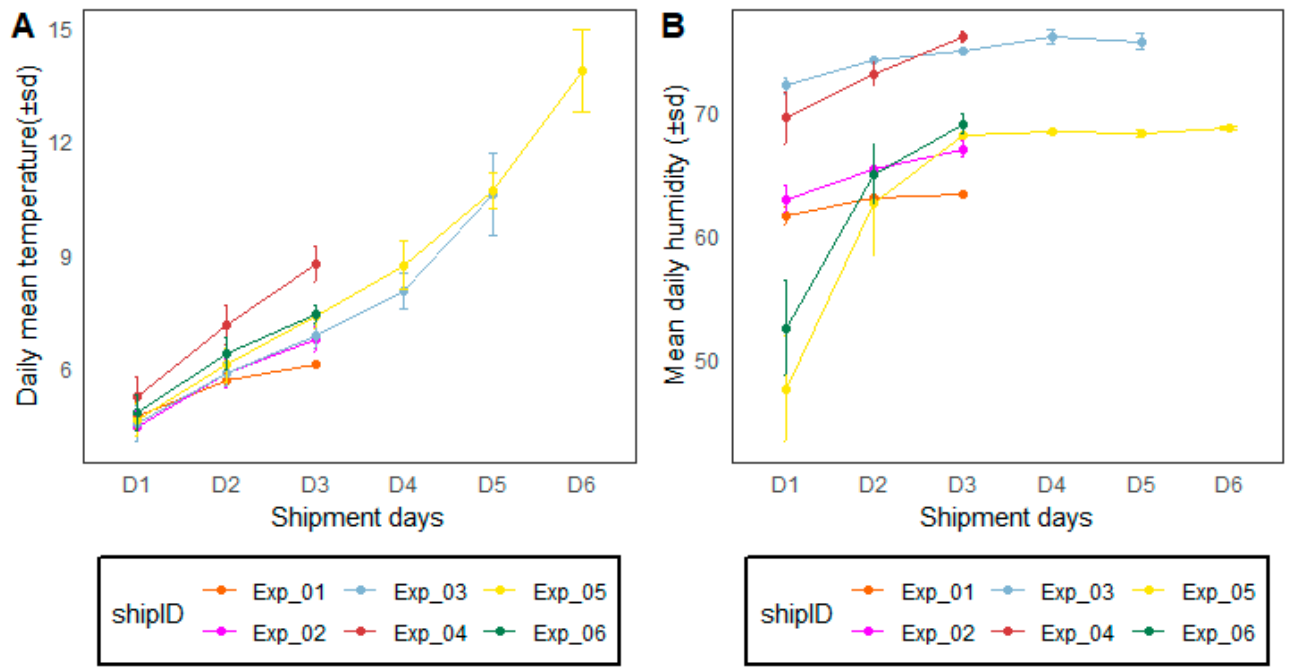
Figure 2. Environmental condition variations including temperature ( A ) and relative humidity ( B ) of six shipments from Seibersdorf, Austria, to Dakar, Senegal, during long-distance transport experiments. Vertical lines separate dates. ‘ShipID’ stands for ‘shipment number (Exp = experiment 01 to 06). ‘D’ stands for ‘shipment day’. Data were recorded using loggers placed at the bottom and top of the mosquito compaction boxes. Loggers were in contact with the Phase Change materials.